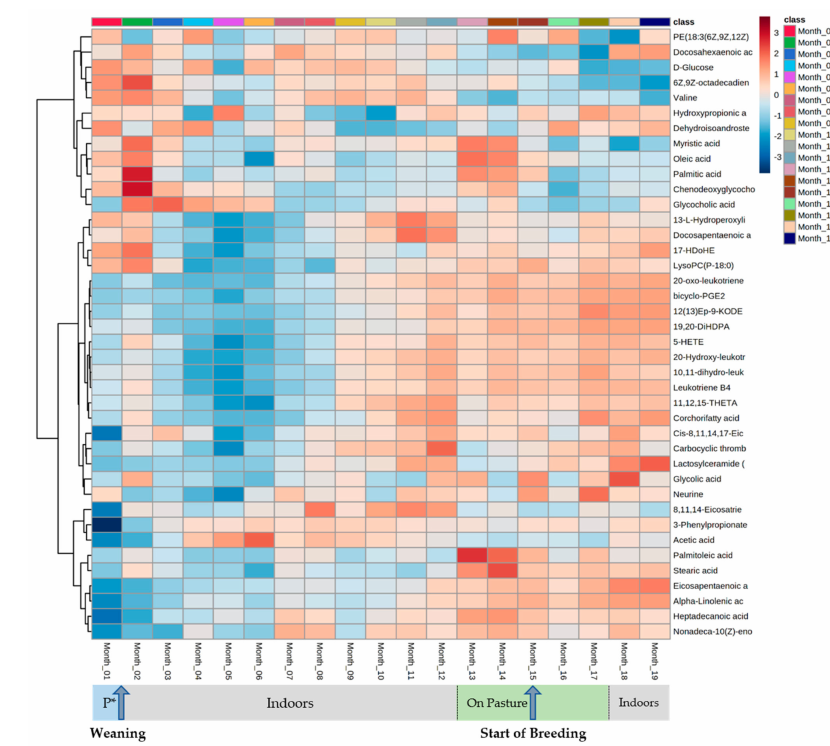
Figure 3. HCA of the major metabolite changes differentiating HF heifers aged between 0.5 and 3.0 months of age in the combined ionization mode m/z